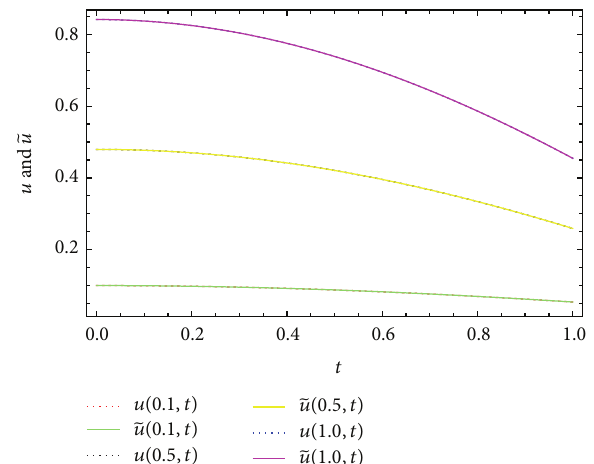
Figure 2: The approximate solution ̃ V of problem (45), where 𝑁 = 16 and 𝛼 = 𝛽 = 0 in the interval [−𝜋,𝜋] .